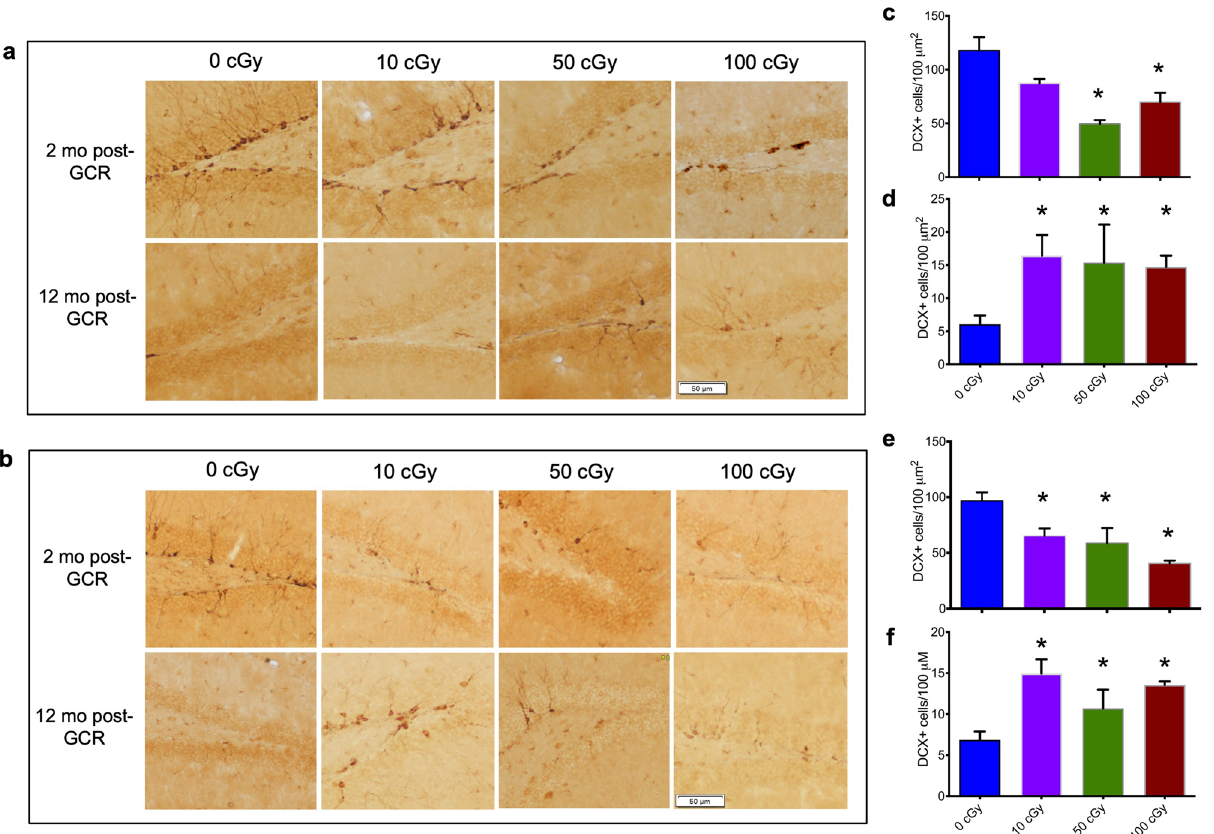
Figure 1. HZE exposure-induced suppression of adult neurogenesis in the dentate gyrus of the hippocampus is transient. Representative images (magnification 10 ×) of immunoreactivity of DCX + cells in coronal brain sections from male ( a ) and female ( b ) mice two months and 12 months post HZE exposure. Quantification of DCX + cell density in sections 2 months post exposure reveals deficits in both ( c ) male mice, One-way ANOVA, F(3,16) = 13.20, P = 0.0001, Tukey’s post hoc test: 0 cGy vs. 10 cGy, P = 0.070 ; 0 cGy vs. 50 cGy, P < 0.0001; 0 cGy vs. 100 cGy, P = 0.003, 10 cGy vs. 50 cGy, P = 0.019, 10 cGy vs. 100 cGy, P = 0.427, 50 cGy vs. 100 cGy, P = 0.312] and ( e ) female mice, One-way ANOVA, F(3,16) = 15.08, P = 0.0001, Tukey’s post hoc test: 0 cGy vs. 10 cGy, P = 0.009; 0 cGy vs. 50 cGy, P = 0.002; 0 cGy vs. 100 cGy, P < 0.0001, 10 cGy vs. 50 cGy, P = 0.862, 10 cGy vs. 100 cGy, P = 0.047, 50 cGy vs. 100 cGy, P = 0.190, but elevated density of DCX + cells 12 months post radiation exposure in both ( d ) male mice, One-way ANOVA, F(3,14) = 4.85, P = 0.01, Tukey’s post hoc test: 0 cGy vs. 10 cGy, P = 0.025; 0 cGy vs. 50 cGy, P = 0.047; 0 cGy vs. 100 cGy, P = 0.046 , 10 cGy vs. 50 cGy, P = 0.988 , 10 cGy vs. 100 cGy, P = 0.947, 50 cGy vs. 100 cGy, P = 0.996, and (f) female mice One-way ANOVA, F(3,12) = 9.92, P = 0.001, Tukey’s post hoc test: 0 cGy vs. 10 cGy, P = 0.002; 0 cGy vs. 50 cGy, P = 0.018; 0 cGy vs. 100 cGy, P = 0.005, 10 cGy vs. 50 cGy, P = 0.123, 10 cGy vs. 100 cGy, P = 0.798, 50 cGy vs. 100 cGy, P = 0.362, compared to age-matched sham-irradiated controls (0 cGy) is shown in bar graphs. * P < 0.05 compared to 0 cGy. Data represents mean ± SEM. n = 5 mice per dose per time point, 6 sections per